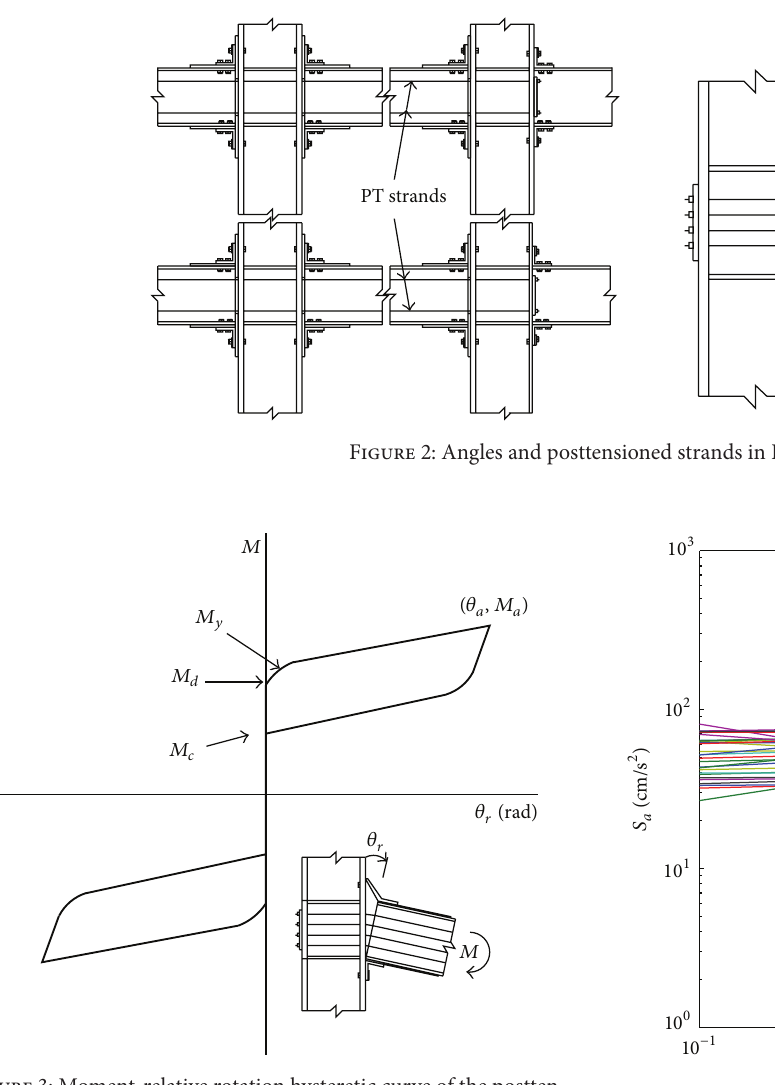
Figure 3: Moment-relative rotation hysteretic curve of the postten- sioned connection.